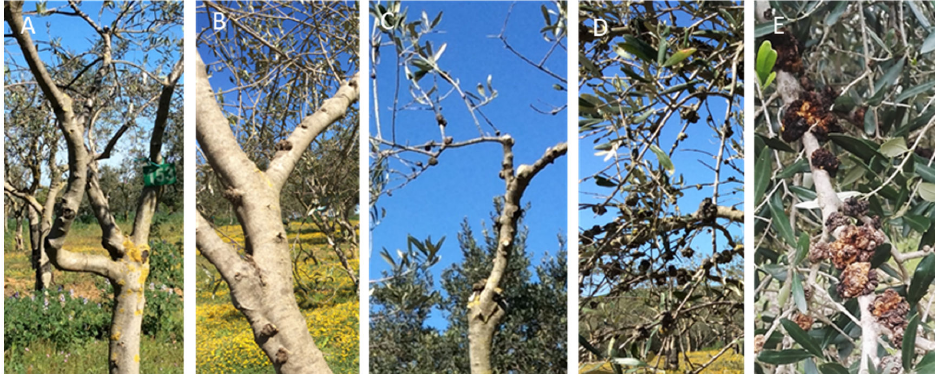
Figure 1. Representative scale of symptoms used for the evaluation of the disease intensity according to Pyrowolakis and Weltzien, 1974 [33]: level 0 ( A ), level 1 ( B ), level 2 ( C ), level 3 ( D ), and level 4 ( E